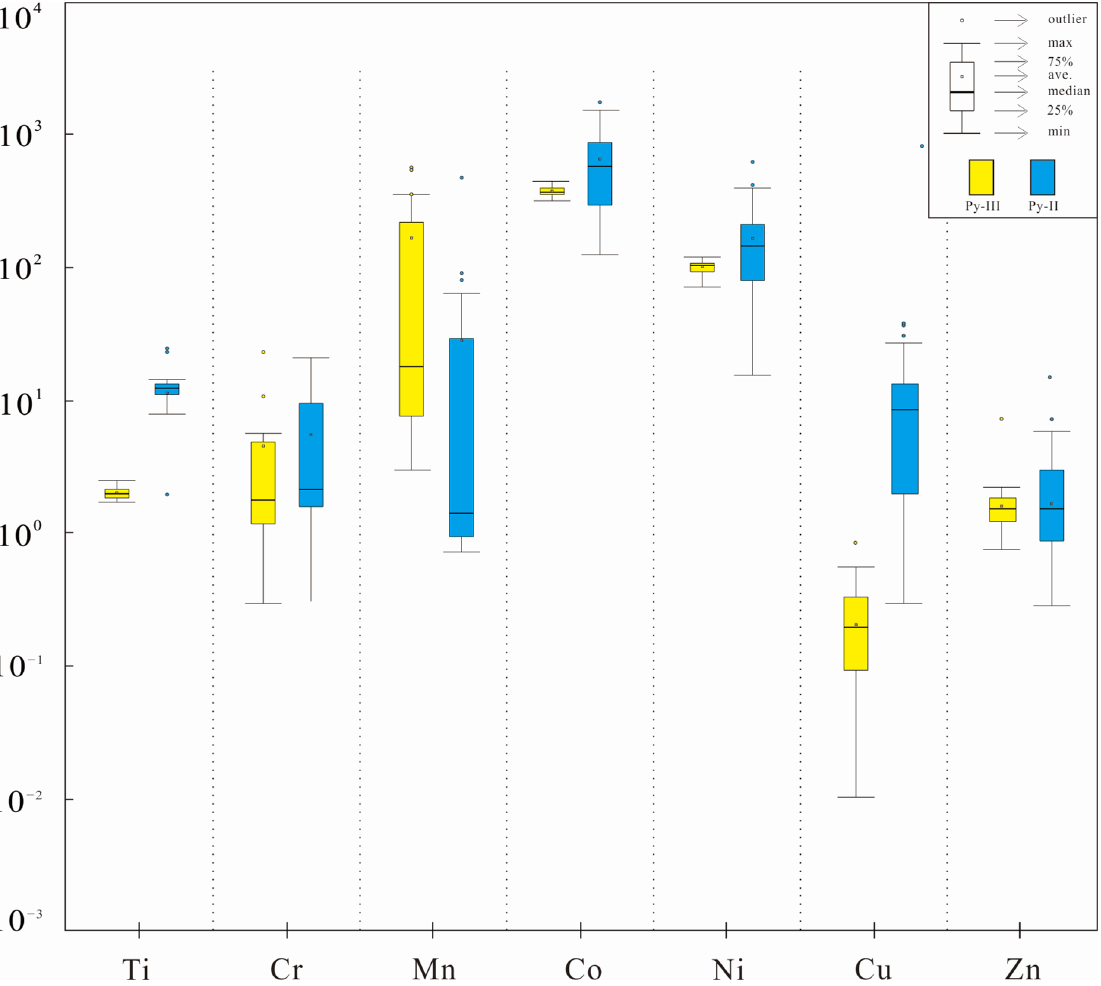
Figure 6. Box and whisker plots of trace element concentrations (Ti, Cr, Mn, Co, Ni, Cu and Zn) determined using LA-ICPMS for different types of pyrite in the Weizigou